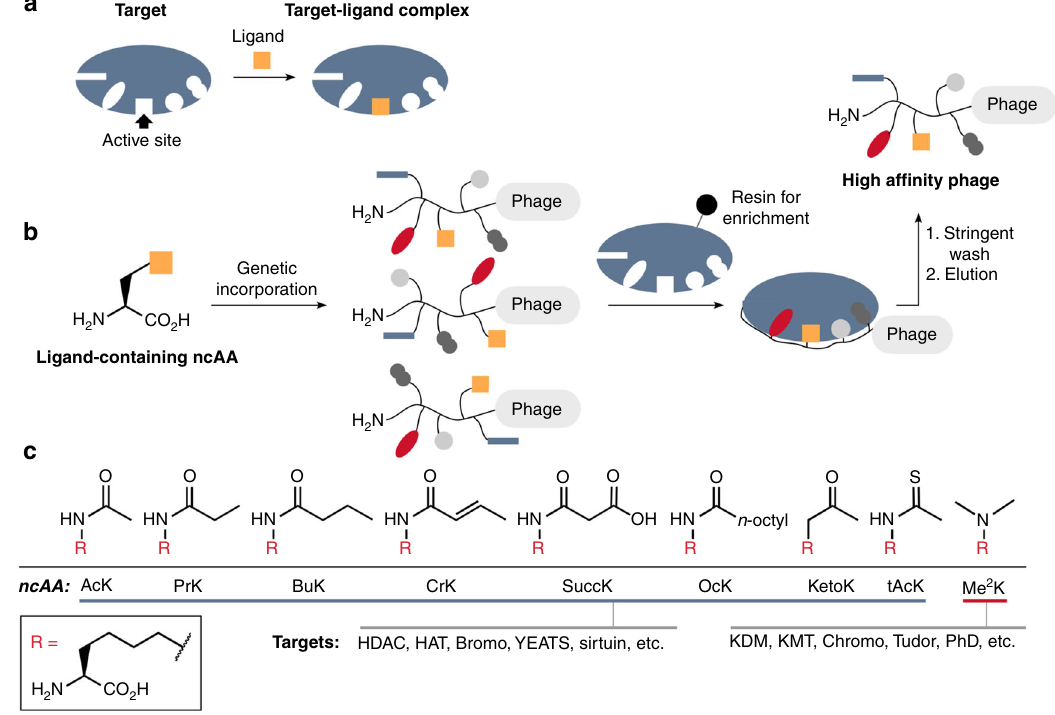
Fig. 1 Overview of phage-assisted active site-directed ligand evolution. a A diagram that illustrates the interaction between a protein target and a ligand. b The genetic incorporation of a ligand-fused ncAA into phage-displayed peptides for active site-directed binding to a protein target that is followed by stringent wash and elution to select high-af fi nity and selective phages. c ncAAs that have been genetically incorporated and can potentially serve as ligands for epigenetic regulators (HAT histone acetyltransferase, KDM protein lysine demethylase, KMT protein lysine methyltransferase, Bromo, YEATS, chromo, Tudor, and PhD are epigenetic reader